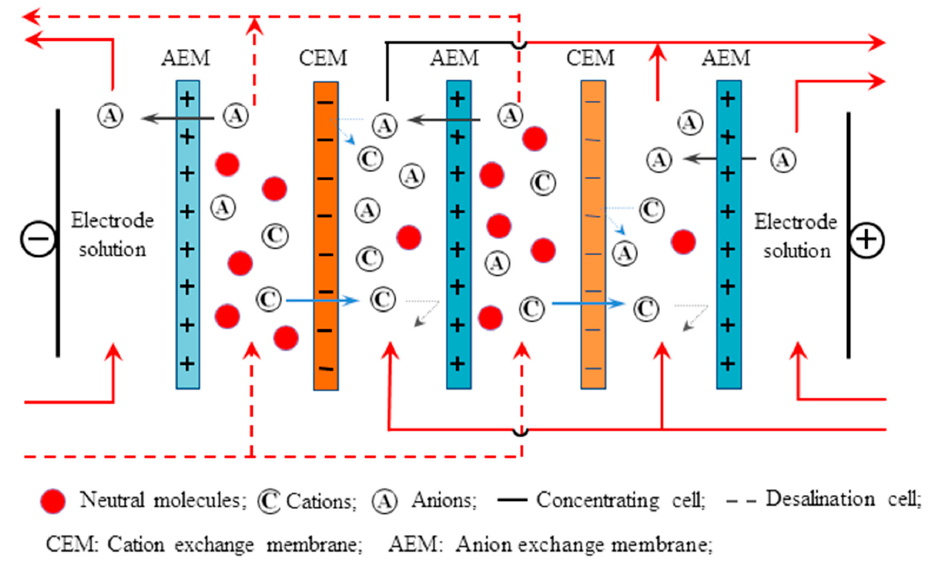
Figure 1. The schematic diagram of an ED stack.